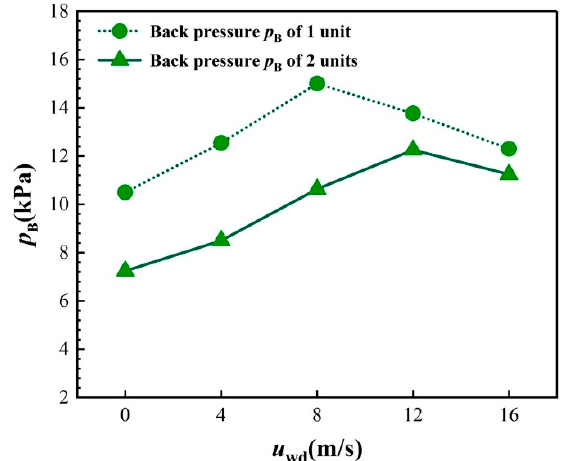
Figure 20. Water outlet temperatures of ACHE in the cases of 2 units and 1 unit under typical crosswind speeds.